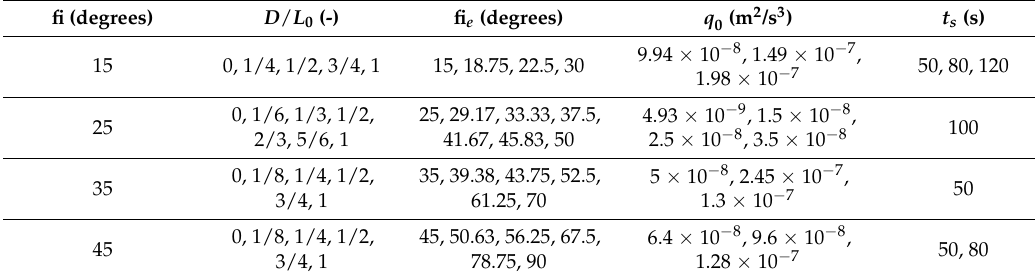
Table 1. Experimental